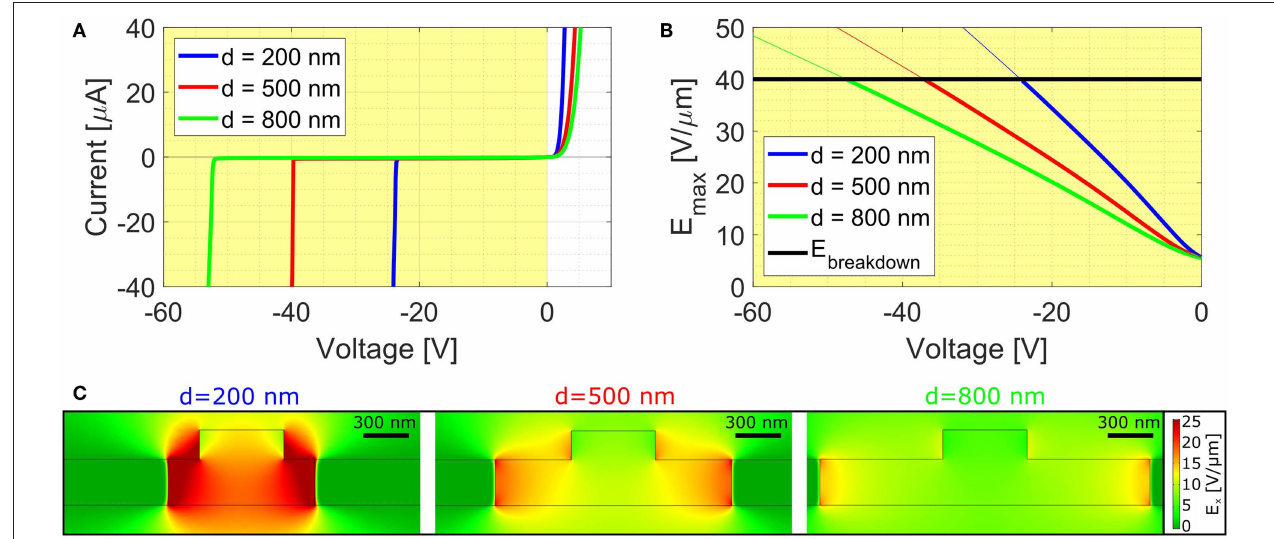
FIGURE 4 | (A) Measured I-V curves of three devices analyzed in this work, referred to d = 200, 500, and 800 nm. (B) Simulated maximum field inside the waveguide as a function of the bias voltage and for the three different d , compared to the breakdown field of silicon (black). (C) Electric field distribution inside the waveguide for different values of d and for a reverse bias of 20 V .